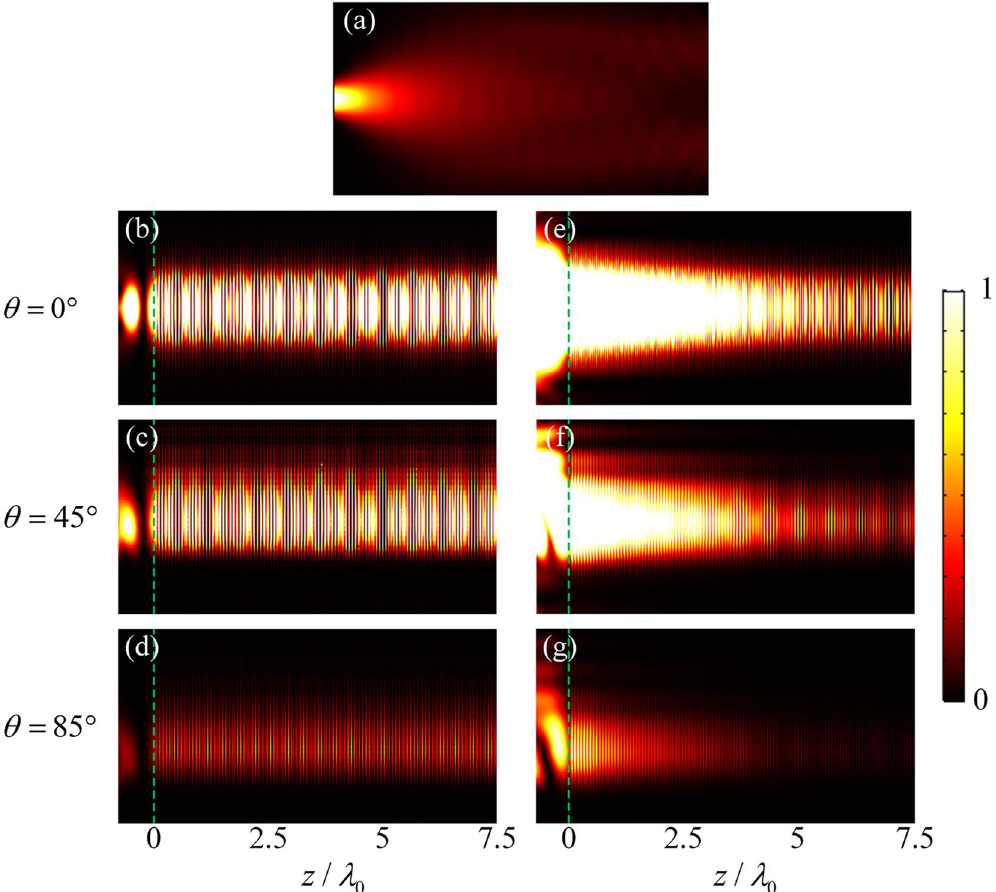
Figure 5. ( a ) Acoustic wave propagates in air. Acoustic waves propagate in the lossless LMMD media with incident angles of ( b ) 0°, ( c ) 45°, and ( d ) 85°. Acoustic waves propagate in the lossy LMMD media with incident angles of ( e ) 0°, ( f ) 45°, and ( g ) 85°. The dashed lines indicate the air-LMMD interfaces.